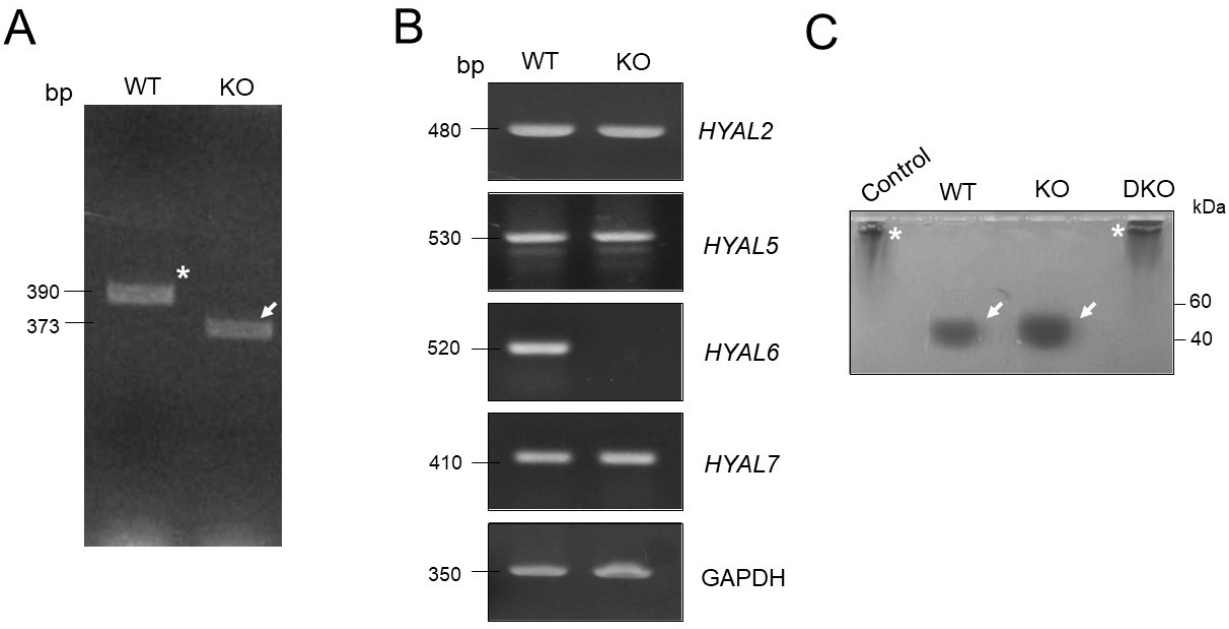
Figure 3. Characterizing male HYAL6 knockout (KO) mice. ( A ) Genomic DNA polymerase chain reaction (PCR) results from wild-type (WT) and KO mice. An asterisk (*) indicates a WT band, and arrows ( → ) indicate Hyal6 KO. ( B ) Reverse transcription PCR analysis of HYAL2 , HYAL5 , HYAL6 , HYAL7 , and glycerol-3-phosphate dehydrogenase (i.e., GAPDH ) using complementary DNA from WT and KO tissues. ( C ) Sperm-specific hyaluronan-hydrolyzing hyaluronidase activity test. Two asterisks indicate high-molecular-weight hyaluronic acid, while two arrows ( → ) indicate low-molecular-weight hyaluronic acid digested by sperm hyaluronidase.